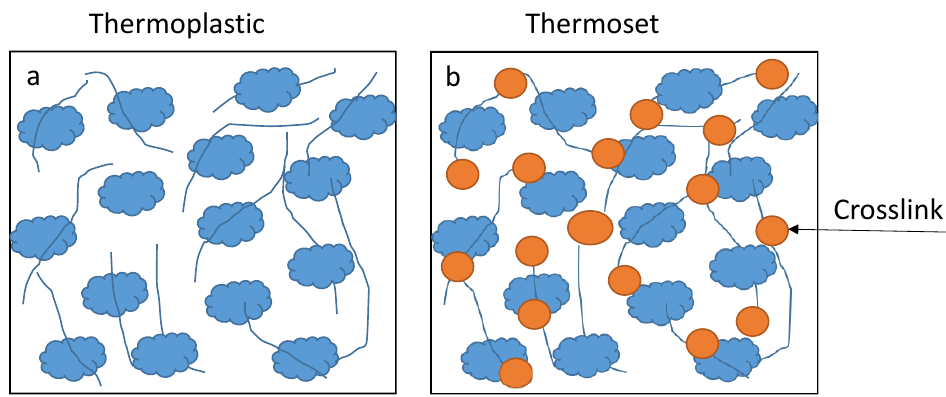
Figure 4 . The crosslinking process between ( a ) weak intermolecular forces and ( b ) strong covalent bonds [46].